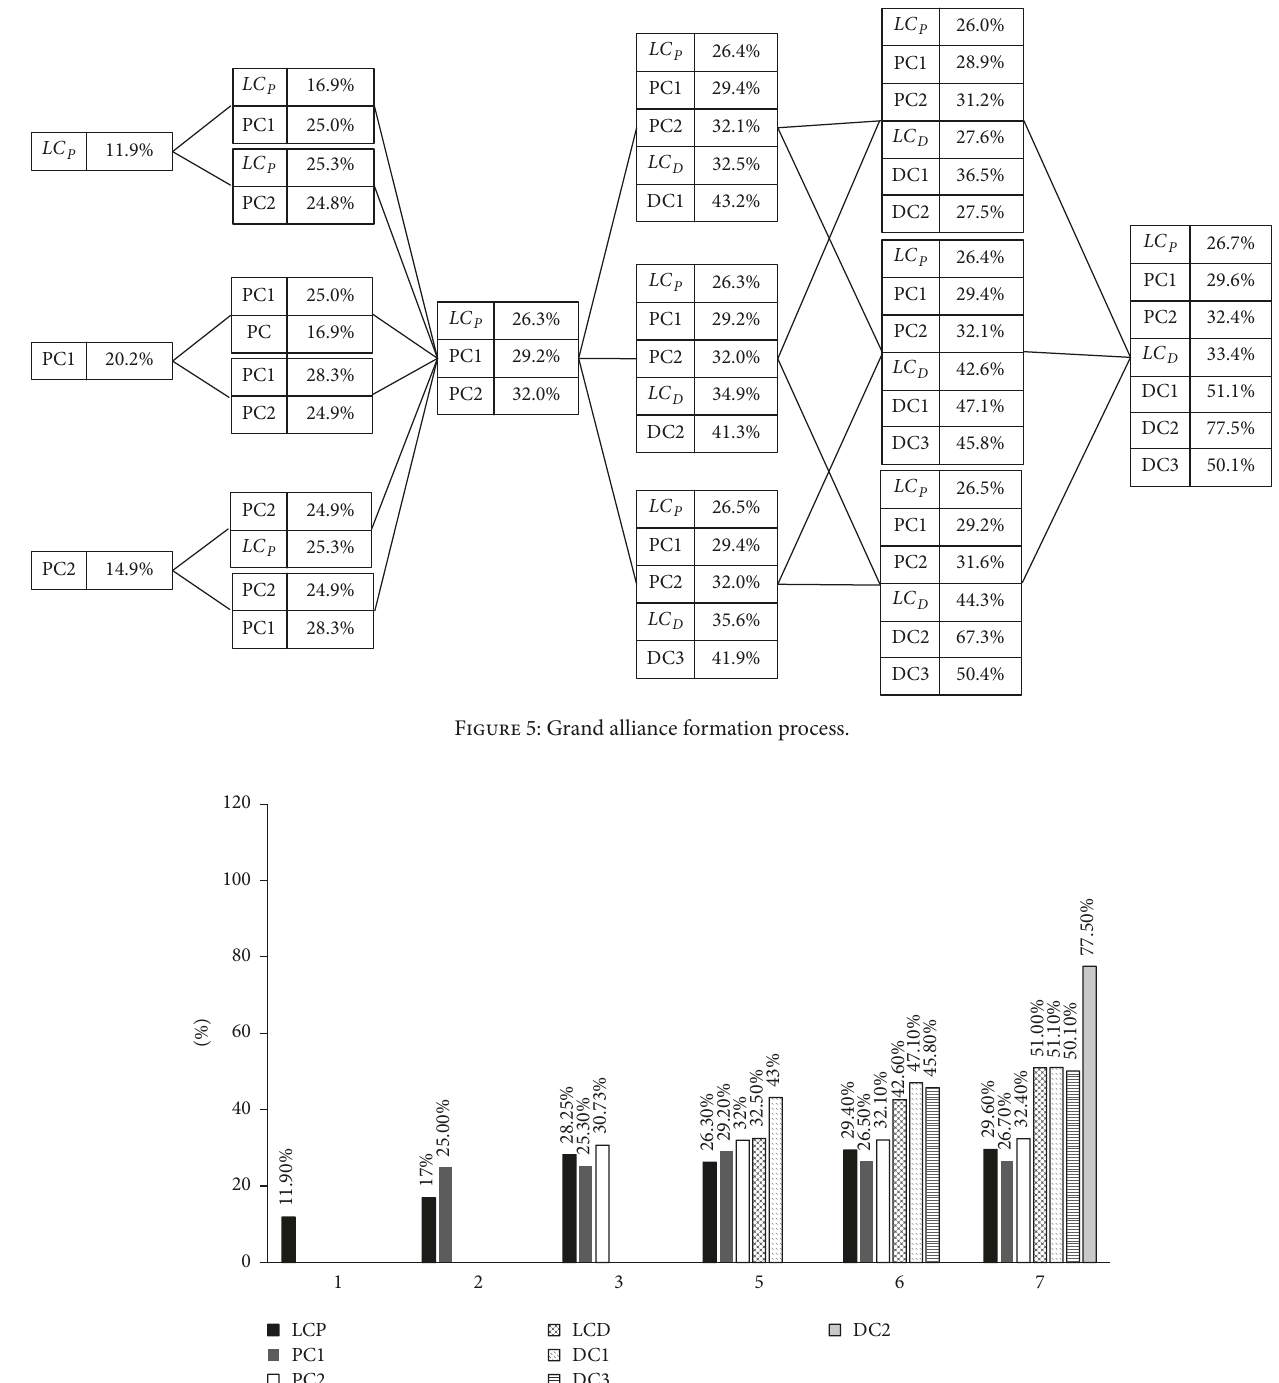
Figure 6: Cost reduction percentage diagram for the grand